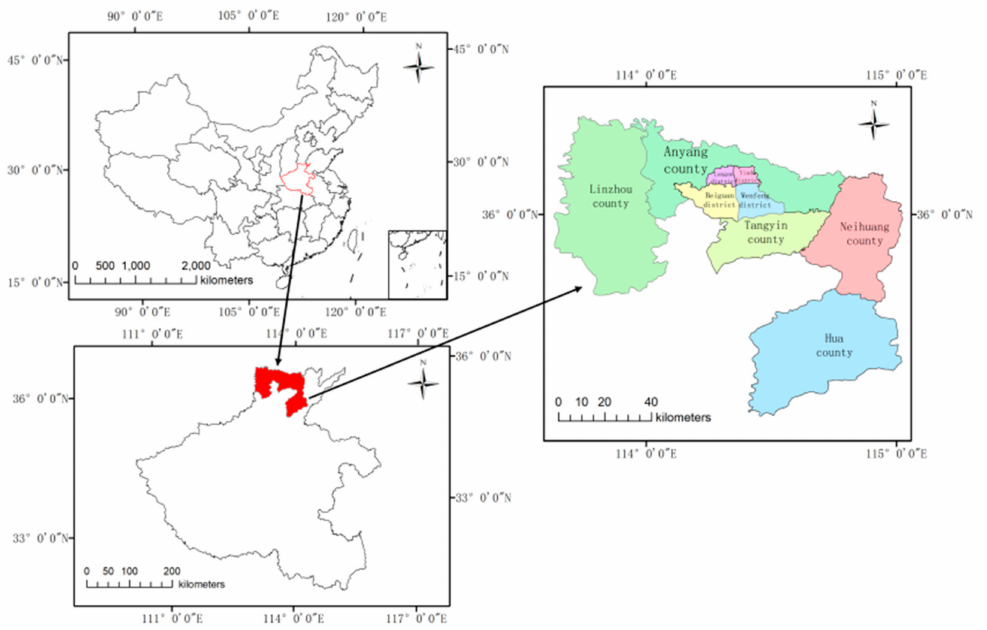
Figure 2. Geographical location and specification of the study area.